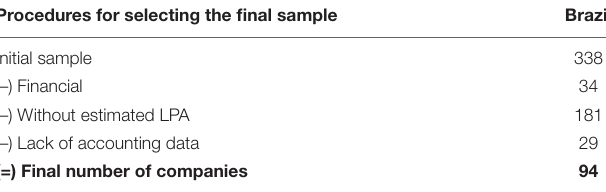
TABLE 1 | Definition of the final sample in 2019. Procedures for selecting the final